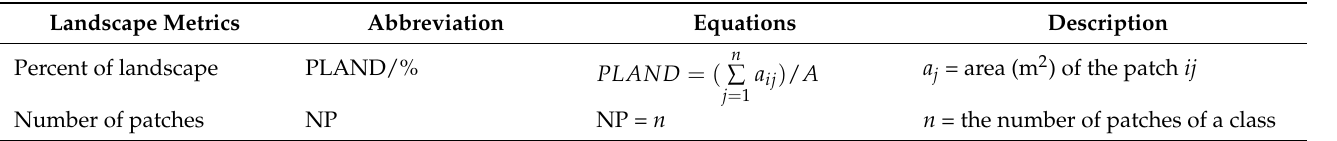
Table 1. Description of landscape metrics used in the study for urban landscape analysis. Landscape